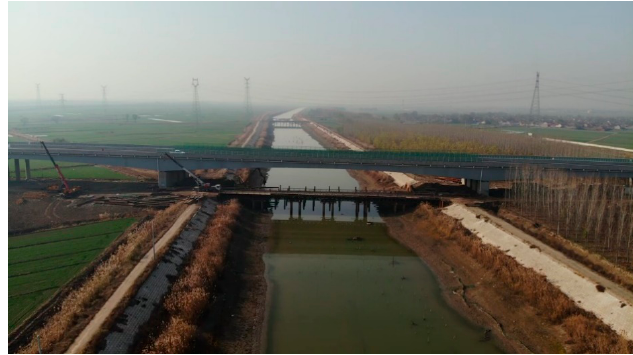
Figure 1. Photo of Xiaoqing River Bridge.